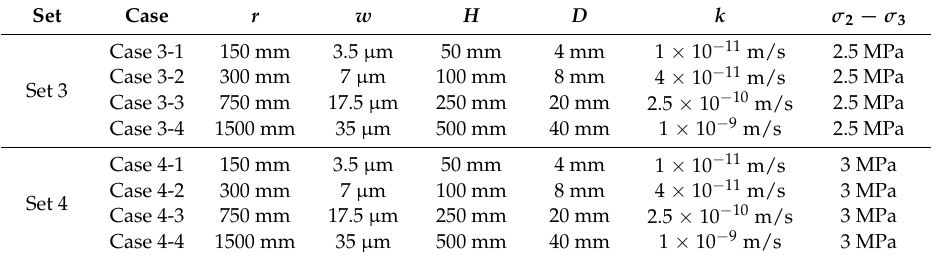
Table 7. Modelling scenarios for studying the validity of Equation (1). The values of parameters related to the pre-located size, the pre-located fracture spacing and the borehole diameter in Cases 3-2 to 3-4 (Cases 4-2 to 4-4) are expanded to 2 times, 5 times and 10 times of that in Case 3-1 (Case 4-1) respectively with the values of other input parameters remaining consistent. The hydraulic conductively ( k ) value in each modelling scenario is scaled to keep modelling scenarios in each modelling set having the same dimensionless rock permeability ( K ) value. The ( σ 2 − σ 3 )/ σ n ratios of modeling Sets 3 and 4 are kept constant as 2.5 and 3 respectively [32].